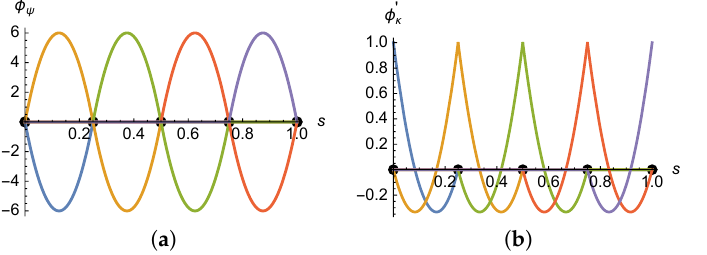
and ( b ) ψ (cid:48) , j = 1, . . . ,5. ψ j κ j